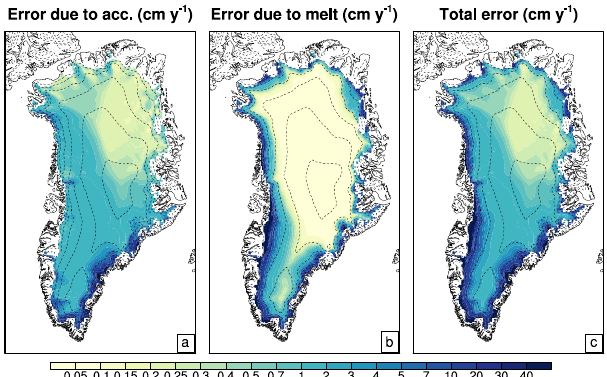
Figure 10. Estimate of errors in firn thickness change (cmyr − 1 ). due to accumulation uncertainty σ ˙ (a) Error σ ˙ h, ˙ b due to melt uncertainty σ ˙ m ; and (c) total error σ ˙ linear colour